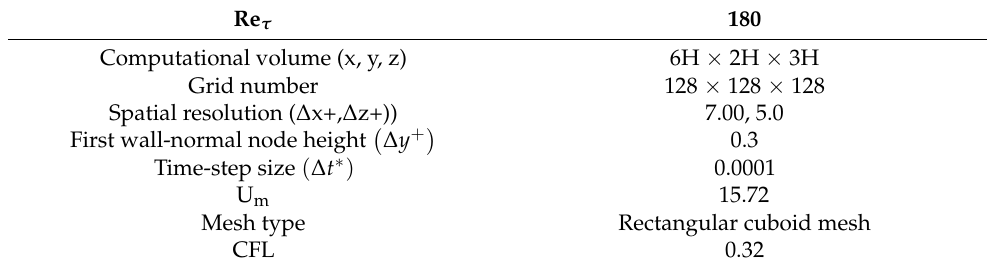
Figure 3. Schematic of the geometry and relevant notation for superhydrophobic surface features: ( a ) ridge type and ( b ) post type.